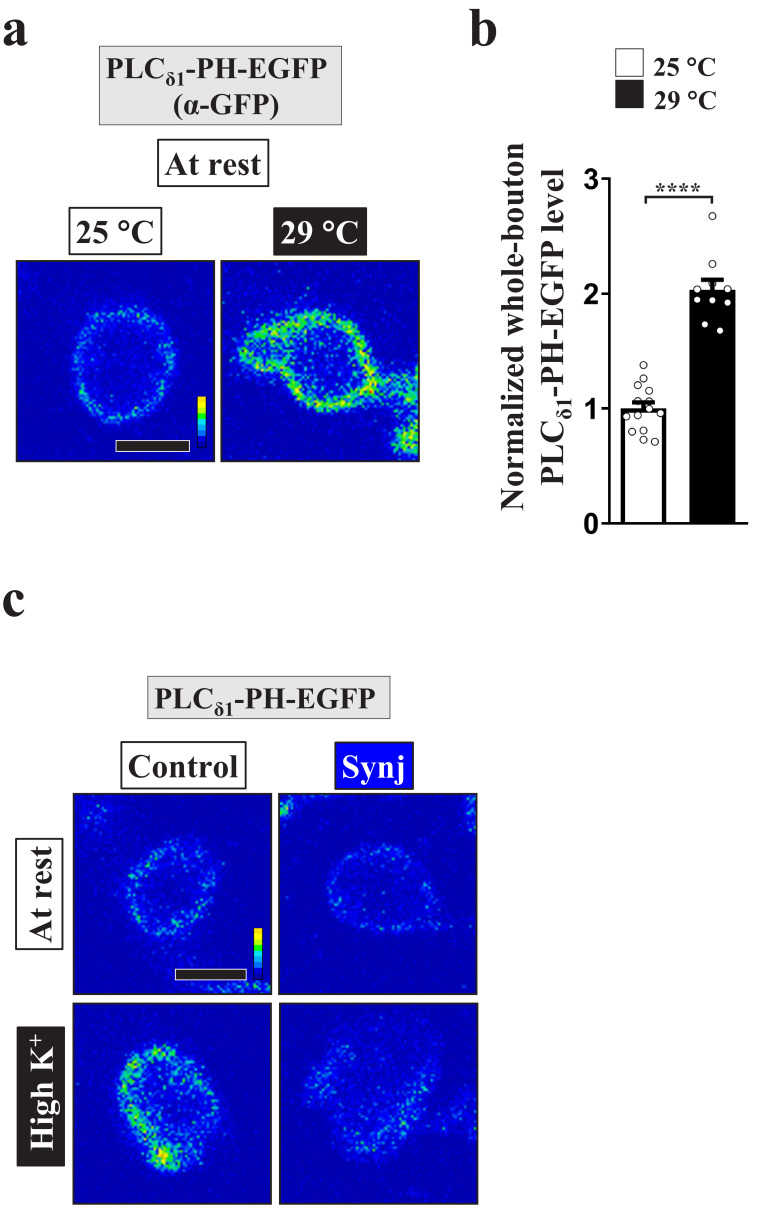
Blockade of the PI(4,5)P2 microdomains by expressing PLCδ1-PH-EGFP and Synj.(a) Increasing rearing temperature from 25°C to 29°C elevated PLCδ1-PH-EGFP expression. Single-plane confocal images of NMJ boutons neuronally expressing UAS-PLCδ1-PH-EGFP using nSyb-GAL4. The boutons were situated at rest and immunostained with α-GFP. (b) Quantification data for the whole-bouton PLCδ1-PH-EGFP immunostaining intensities, normalized to the value for the 25°C condition. Individual data values are shown in graphs. p values: ****p<0.0001. Mean ± SEM. Scale bar: 2 µm. Statistics: Student t-test. (c) Synj expression suppressed PI(4,5)P2 microdomain formation. Single-plane confocal images of NMJ boutons co-expressing UAS-PLCδ1-PH-EGFP with UAS-RFP control or UAS-Synj at 25°C. The boutons were subjected to the resting condition (10 min incubation of 5 mM K+/0 mM Ca2+) or high K+ stimulation (10 min stimulation of 90 mM K+/2 mM Ca2+), followed by chemical fixation and α-GFP immunostaining. Scale bar: 2 µm.
Figure 2—figure supplement 1—source data 1.Source data for Figure 2—figure supplement 1.